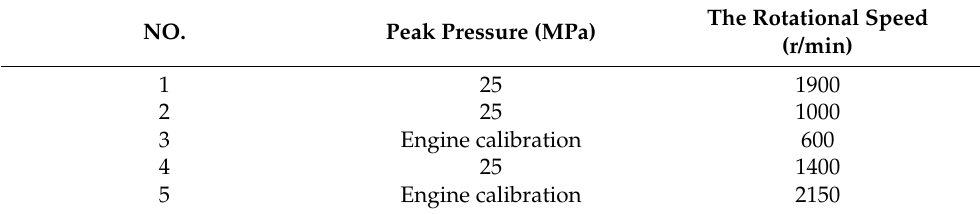
Table 3. Test cycle conditions.